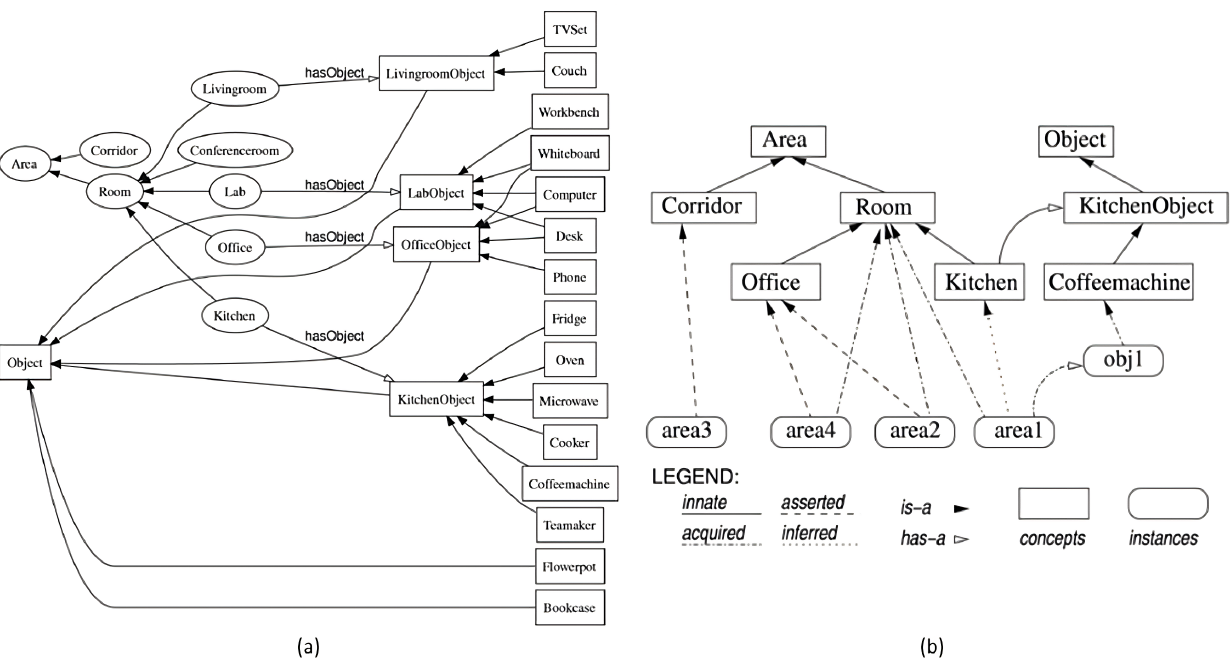
Figure 3. The example of reasoning-based data acquisition in [23]. ( a ) Illustration of a part of the common-sense ontology of an indoor office environment, ( b ) combining different types of knowledge in the conceptual